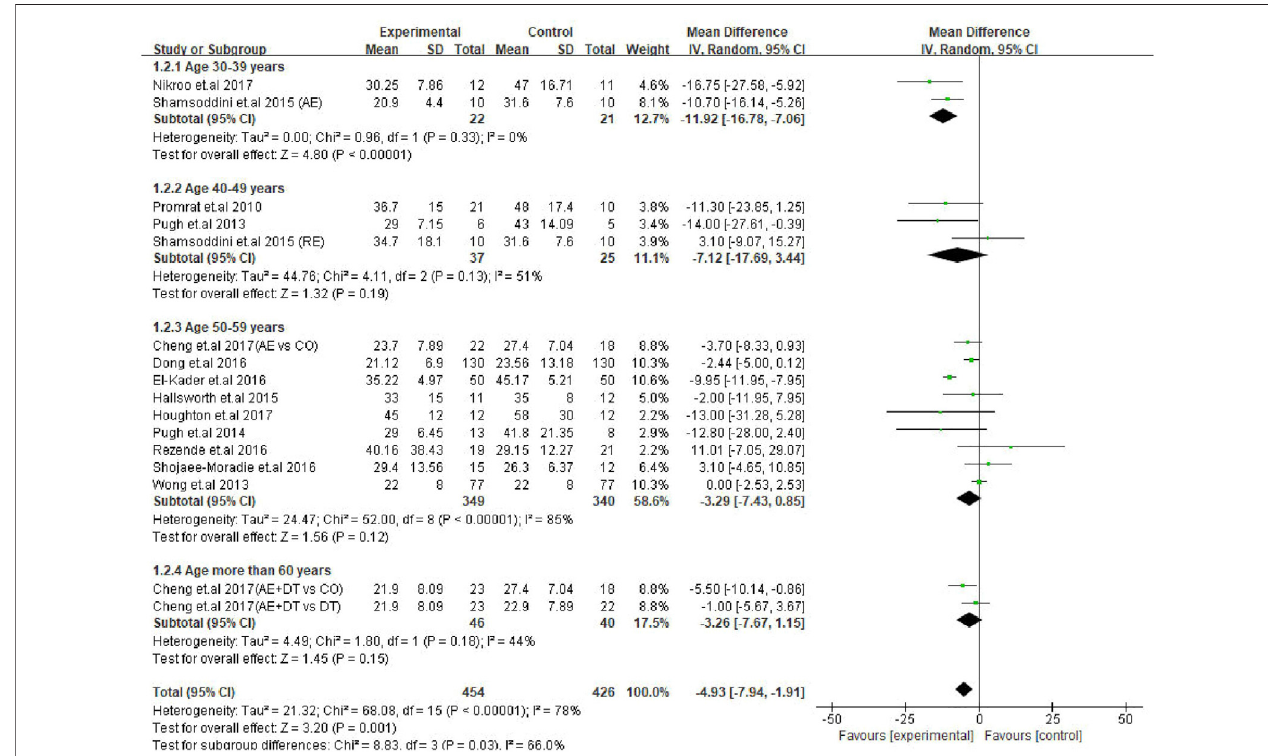
FIGURE5| Subgroupanalysisofexerciseintervention onchangesinASTlevelsindifferentagegroupsofNAFLD/NASH patients.SD,standarddeviation;95%CI, 95% con fi dence interval.